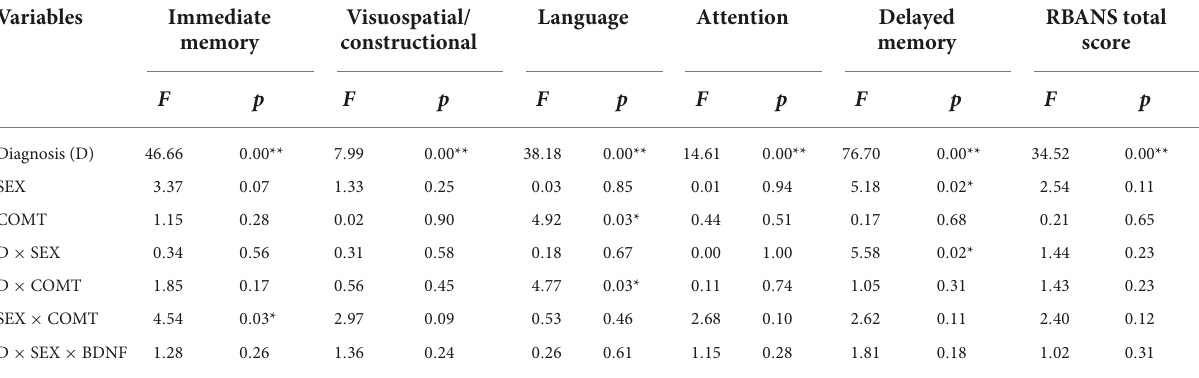
TABLE 2 Interaction of diagnosis, sex, and catechol O methyl transferase Val158Met (rs4680) genotype on the cognitive performance.